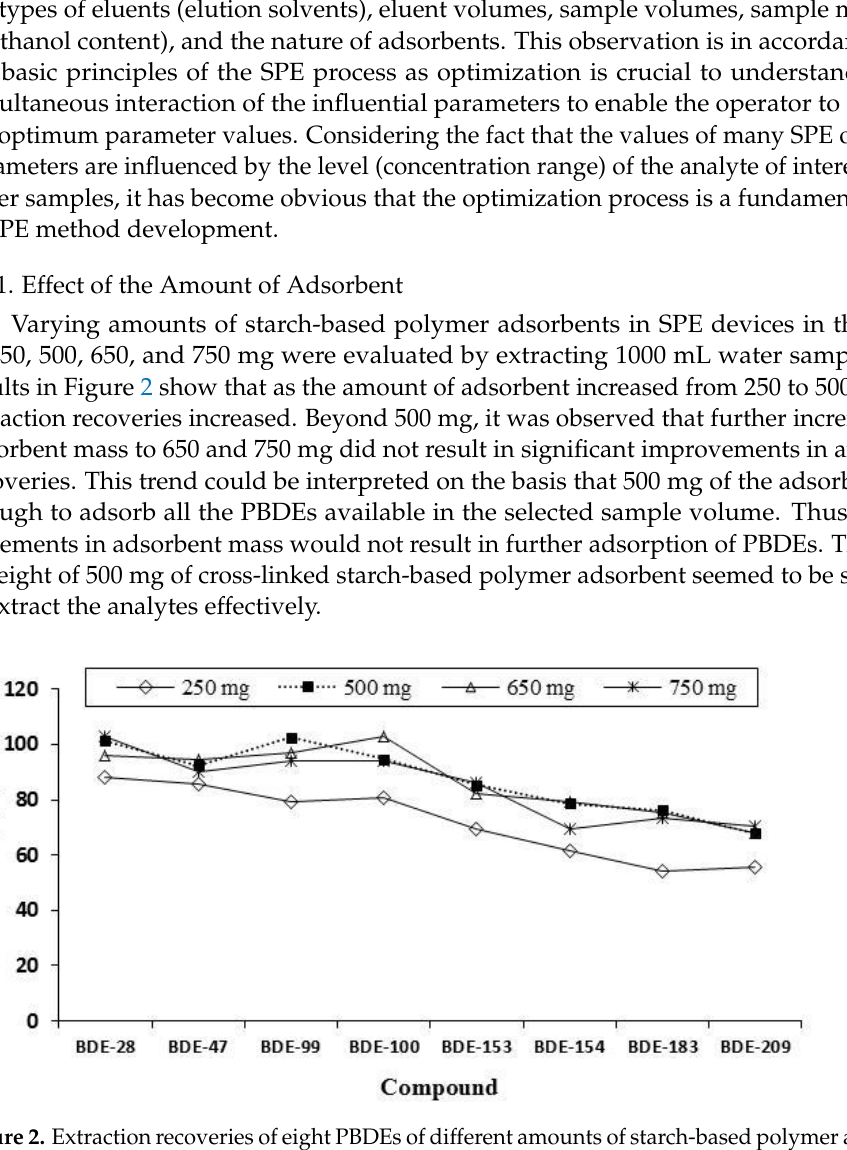
Figure 2. Extraction recoveries of eight PBDEs of different amounts of starch-based polymer adsorbent ( n = 3).